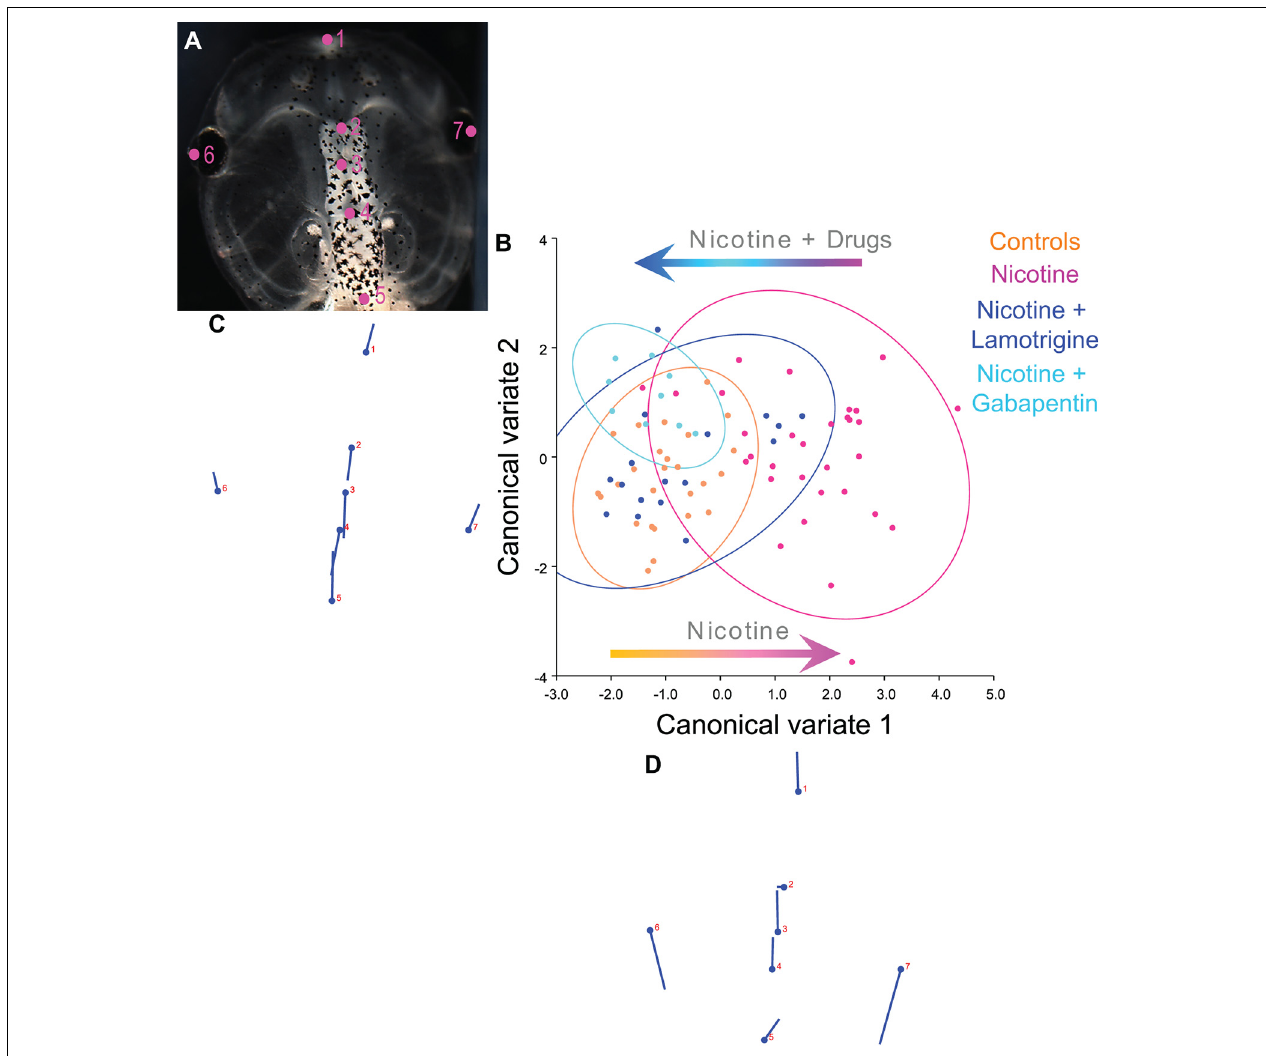
FIGURE 8 | Lamotrigine and Gabapentin restore the brain size relation to anterior head shape in nicotine-exposed embryos. (A–D) Morphometrics canonical variate analysis of brain size in proportion to head shape of stage 45 tadpoles. Representative image of a stage 45 control tadpole (A) illustrating the seven landmarks used in this analysis. (B) Canonical variate analysis, showing confidence ellipses for means at a 0.95 probability of shape data. Confidence ellipses are colored to correspond with treatment as indicated. Lamotrigine and gabapentin treatments were from stage 10–35. N > 10 for each group. Procrustes distances: Control vs. nicotine = 0.12, control vs. nicotine+lamotrigine = 0.04, control vs. nicotine+gabapentin = 0.06. ANOVA of centroid shape between the controls, nicotine+lamotrigine, and nicotine+gabapentin in relation to nicotine treatment confirmed significant differences between the groups ( F = 8.2, p < 0.0001). (C,D) Canonical variate axis legend showing the movement of each of the seven landmarks. Each ball represents the landmark as indicated by the number and the accompanying stick represents the direction and extent of movement of that particular